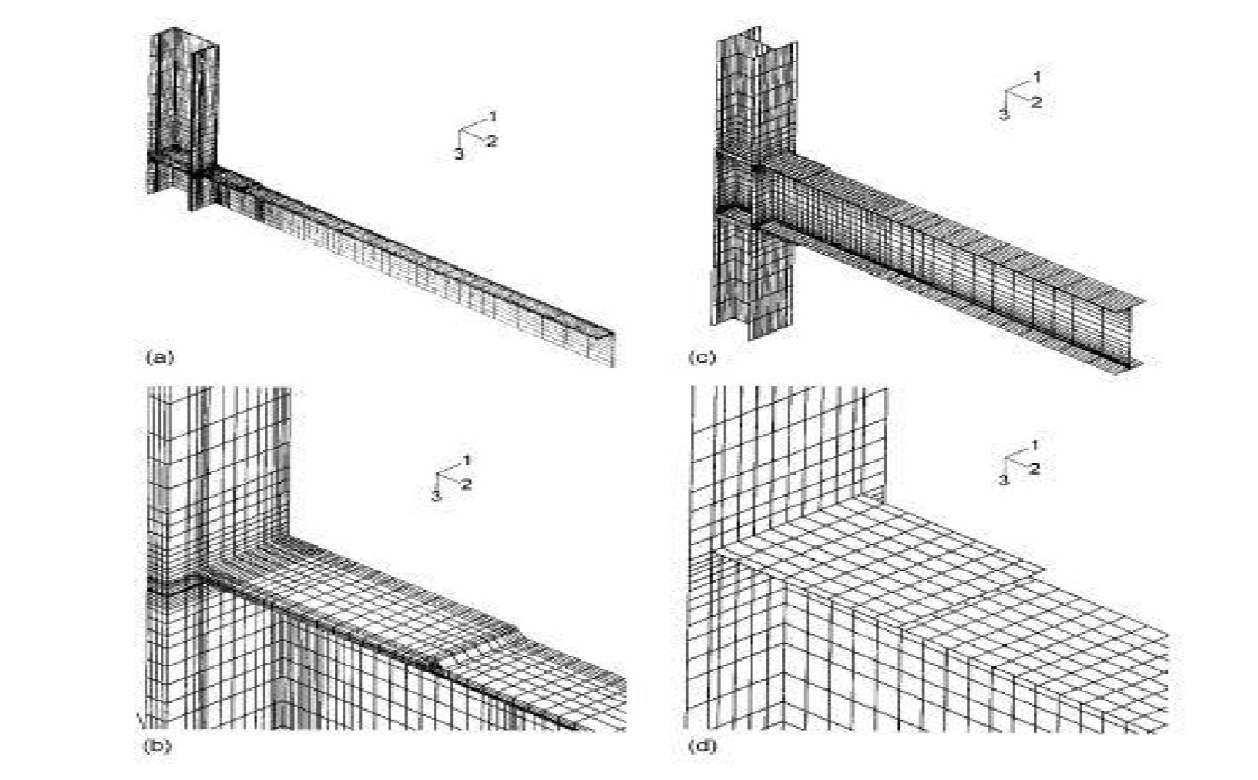
Figure 4. Finite element model of RCO3: (a) global view of SOL model; (b) local view of SOL model; (c) global view of SH model; (d) global view of SH model This design allows for replacing slit dampers as bottom flange joint parts, allowing structures to be used after an earthquake. The suggested structural system uses the connection between the beam top flange and the column flange to transmit gravity loads from the beams to the columns because the major retrofit work after an earthquake is performed near the bottom flange. Because the center of rotation remains at the top flange of the beam, the Split-T at the top flange can be kept in an elastic range. When the structure deforms under earthquake load, the deformation is concentrated on the dampers at the bottom flange when utilizing these systems with a triangular and cubical shape. When considering the plastic hinge of beam- ends, the proposed structural system can be characterized as a "strong column weak beam" since the plastic deformation is concentrated on the dampers in the